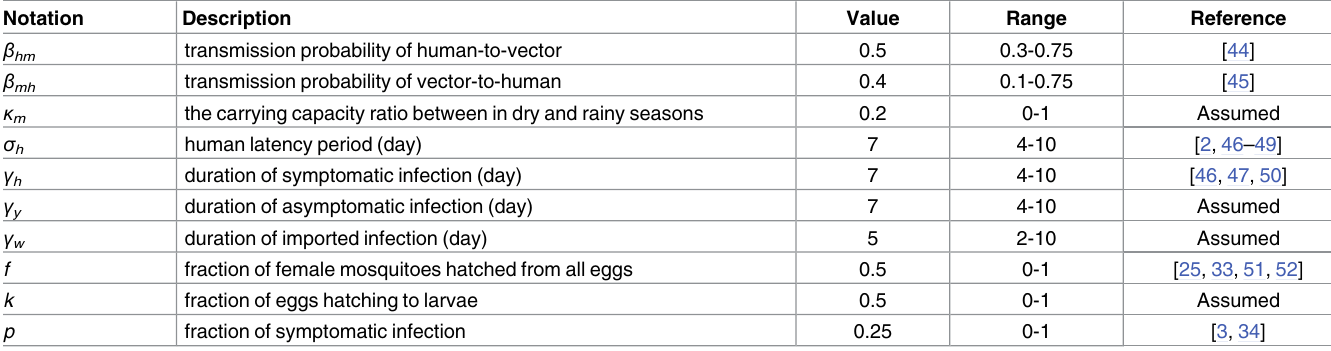
Table 3. Some parameters description and